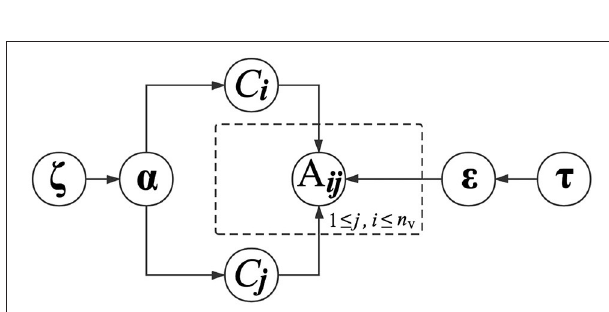
FIGURE 2 | Graphical model representation of generating